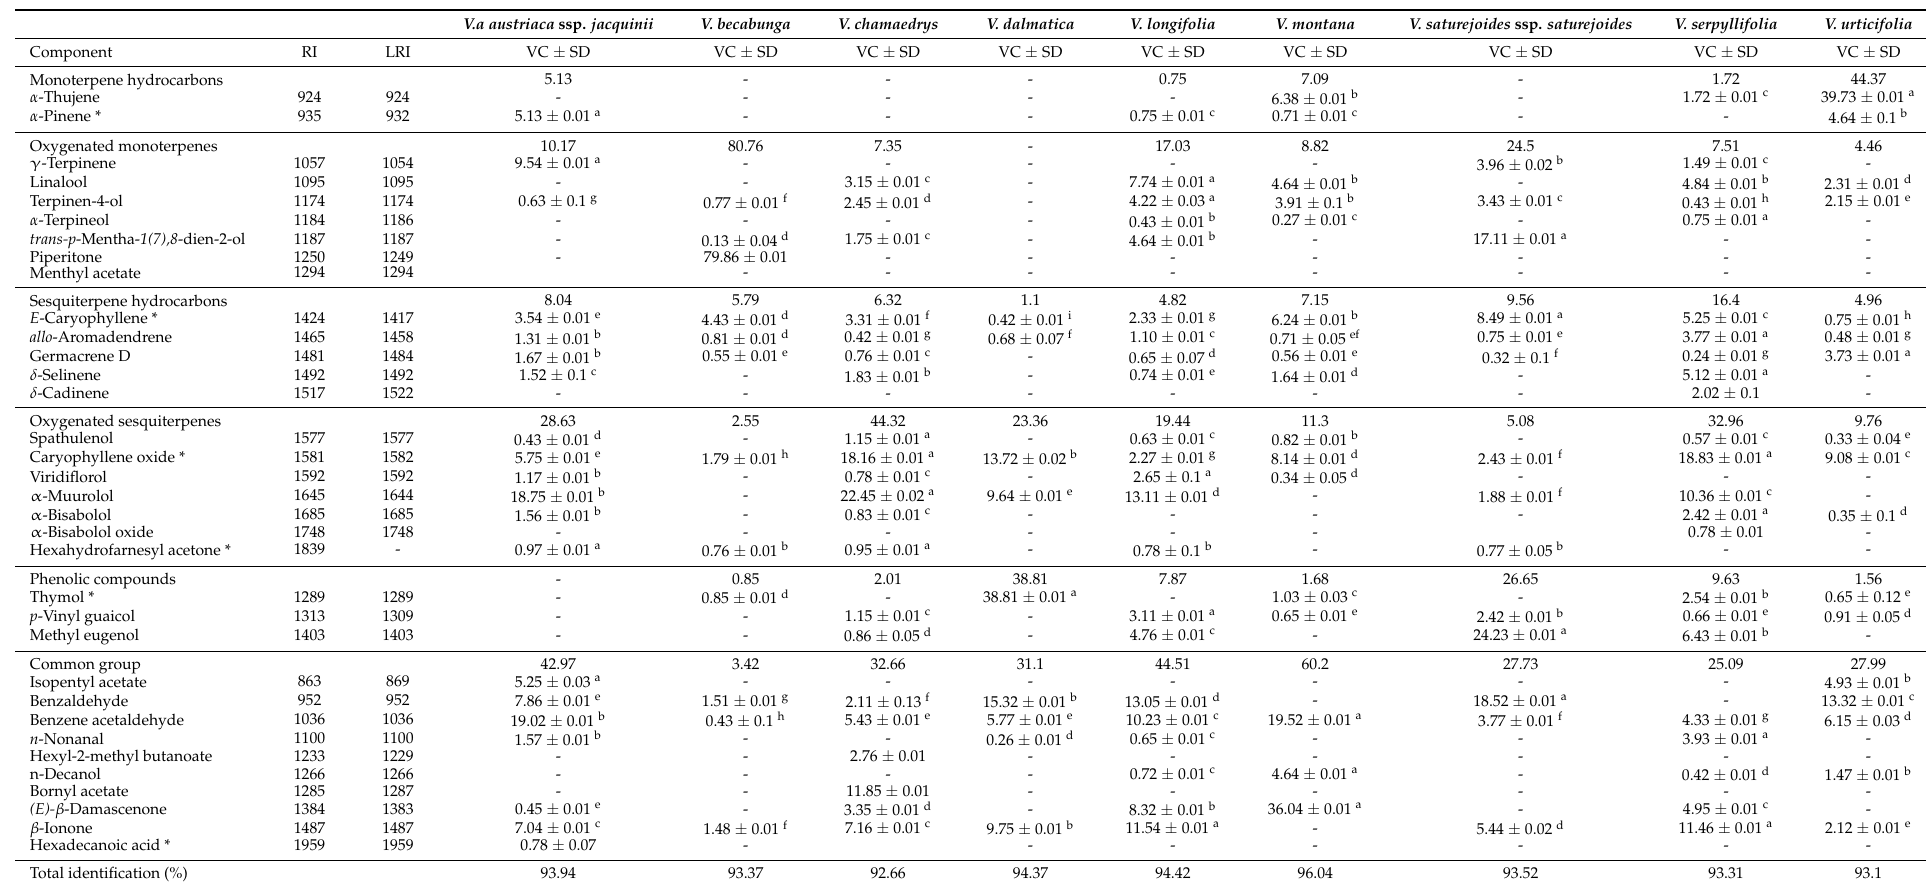
Table 3. Components of the hydrosols (%) obtained by microwave-assisted water extraction from the aerial parts of Veronica